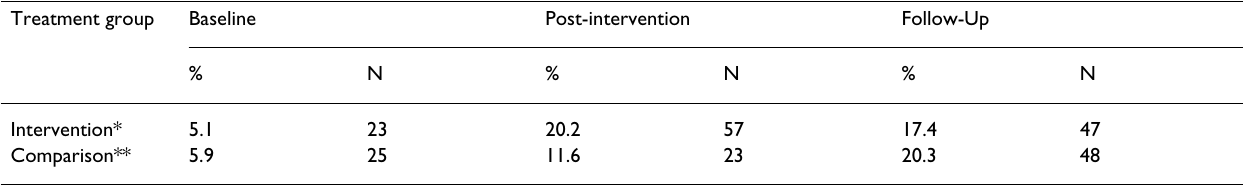
Table 3: Percentage distribution of women who had an opportunity to ask questions Treatment group Baseline